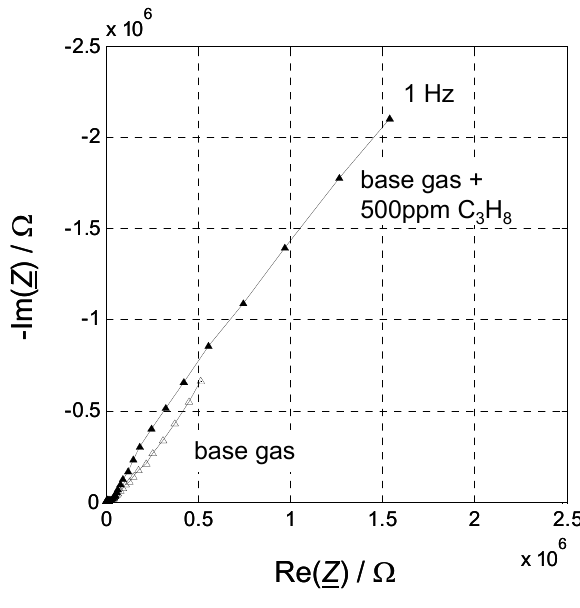
Figure 8. Calculated electrode spectra in base gas and after adding of 500 ppm C